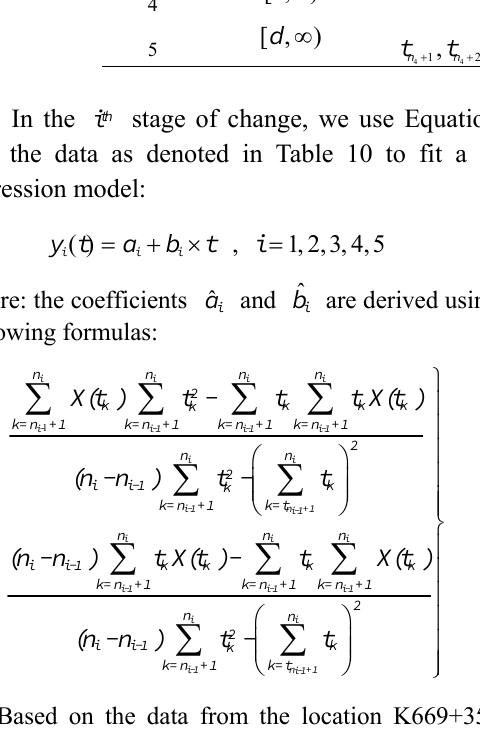
Table 11 Multi-stage Linear Fitting Model for Changes in Right Track Surface at Mileage Point of K669+350 in Jing-Hu Up-Going Track